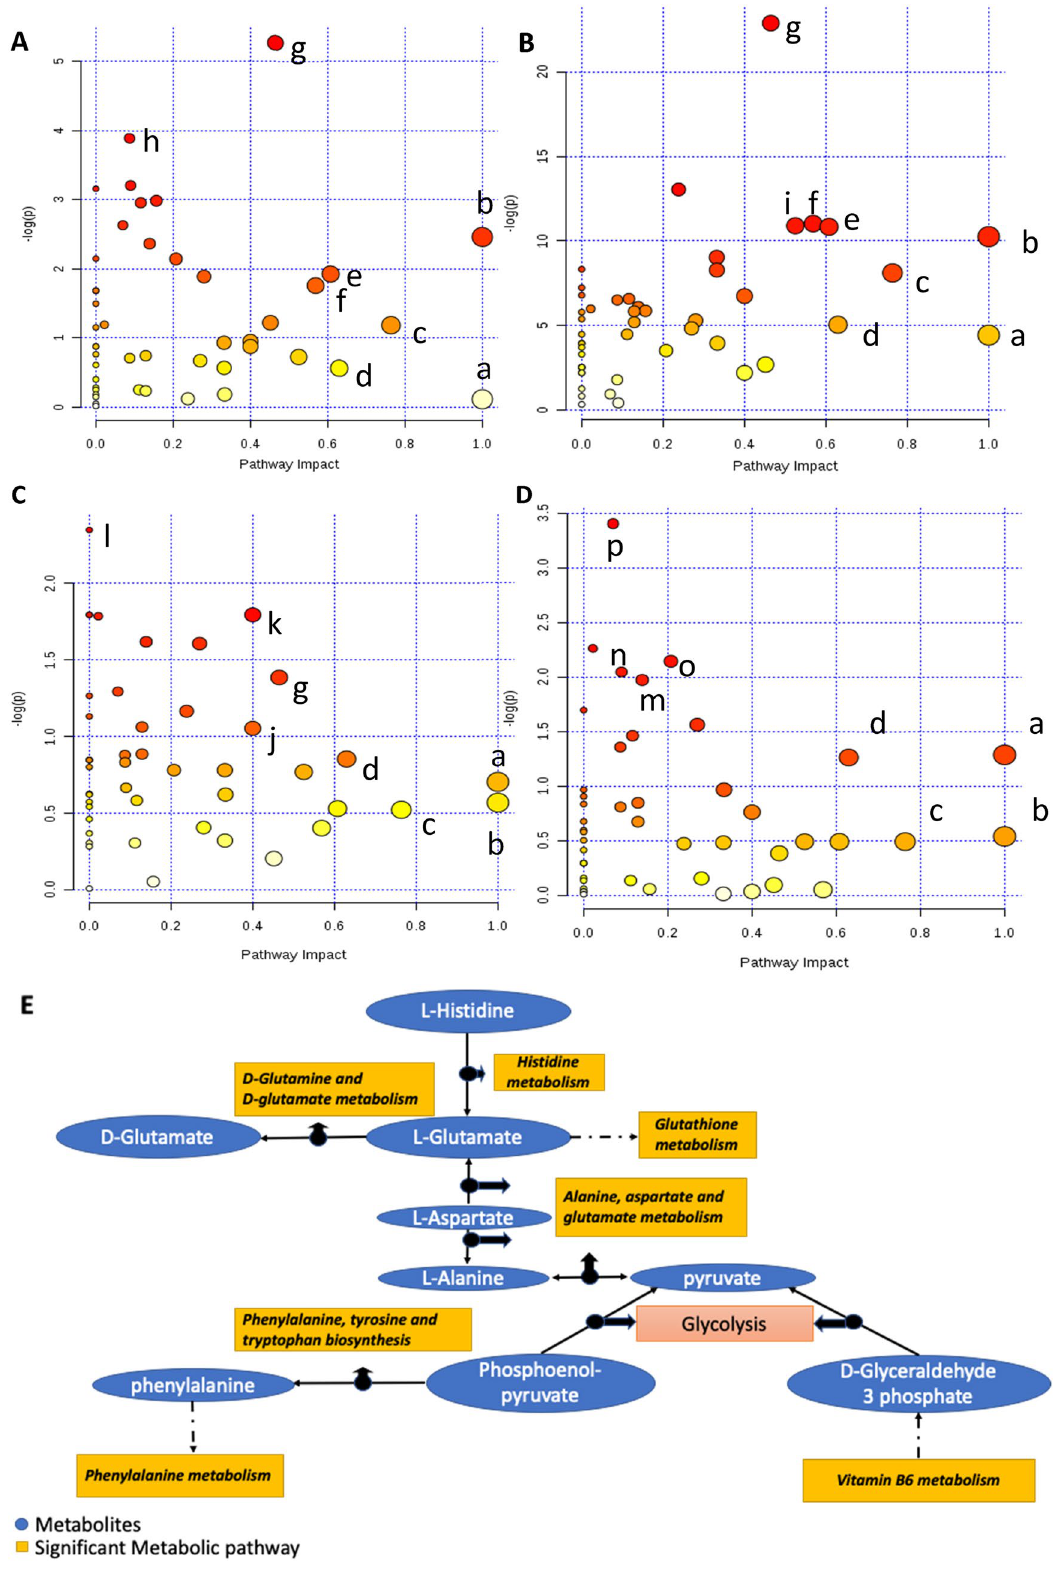
Figure 7. Host metabolism pathway analysis on plasma samples. Female PBS versus B0 ( A ); female PBS versus B20 ( B ); male PBS versus B0 ( C ) and male PBS versus B20 ( D ). Detailed metabolic pathways information is listed in Table S2. Significantly altered metabolites and their pathways were summarized in the pathway tree plot ( E